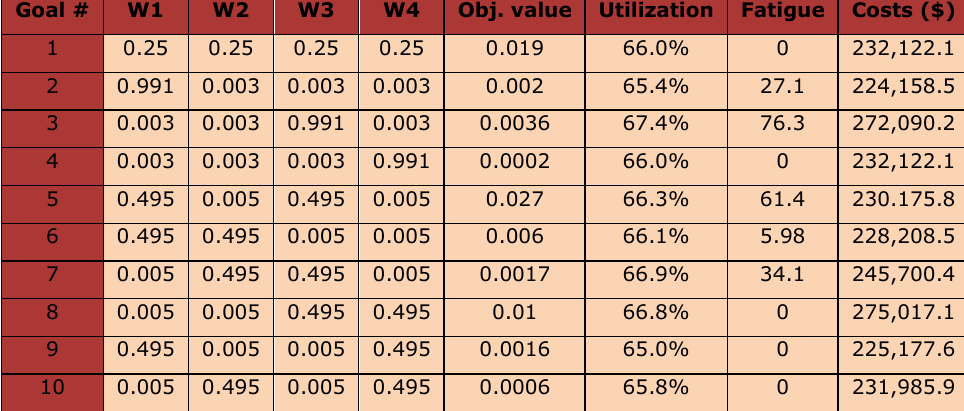
Table 11. Comparisons between Different